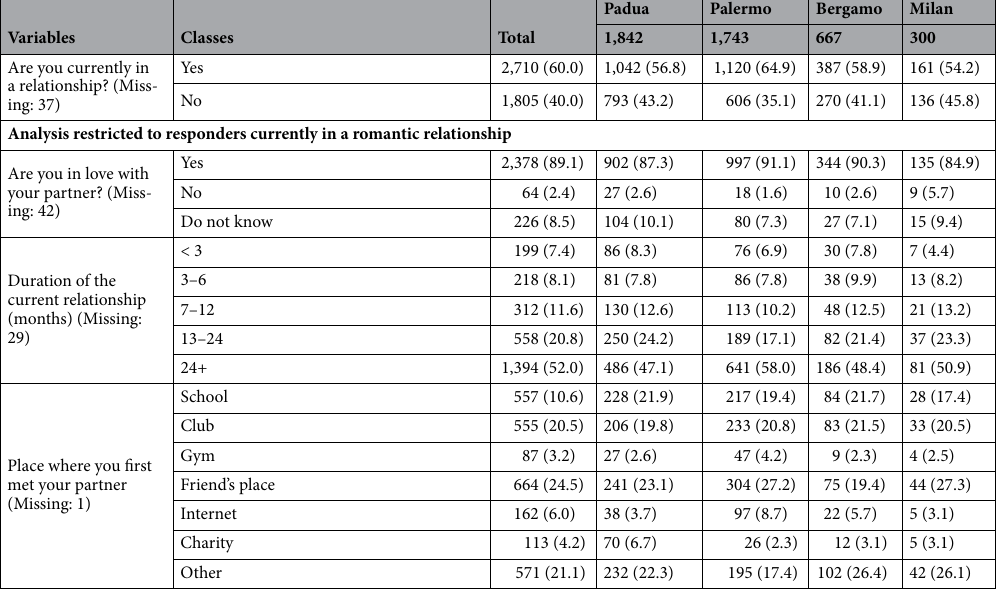
Table 2. Distribution of variables by university campus. Number and column percentage (%).